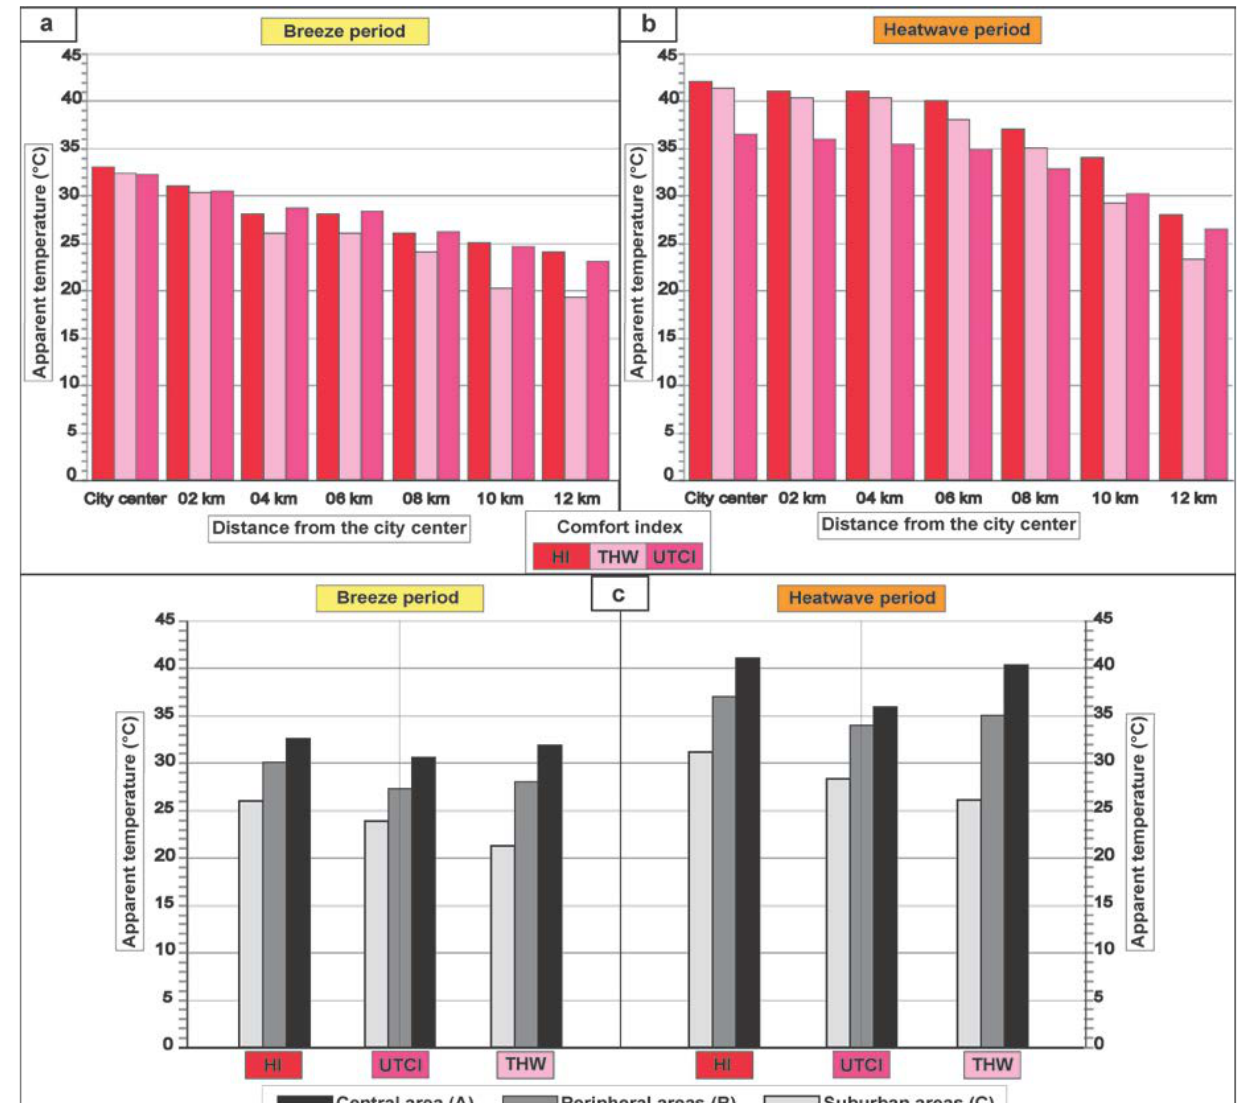
Figure 3. ( a ) HI, UTCI and THW comfort indices calculated between the central part and 12 km from the city centre in breezy weather; ( b ) in hot weather (Sirocco); ( c ) HI, UTCI and THW comfort indices calculated in areas A, B and C in breezy weather and hot weather (Sirocco) during night.